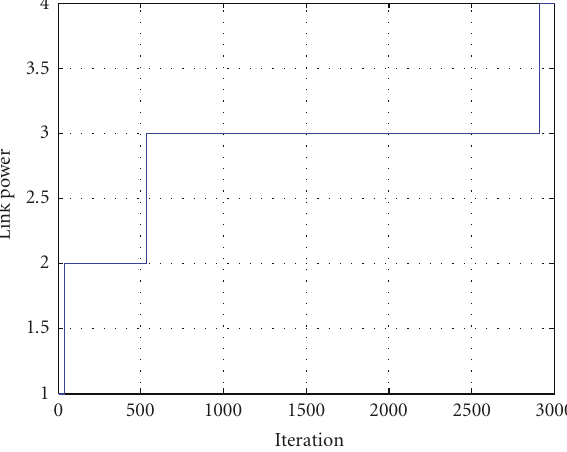
Figure 10: Power of links 1, 2, 3, and 6.